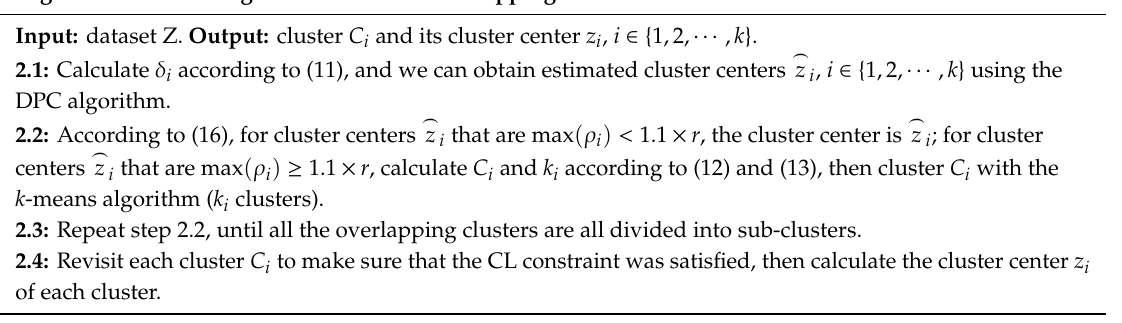
Algorithm 2 Clustering with at least one overlapping cluster in dataset